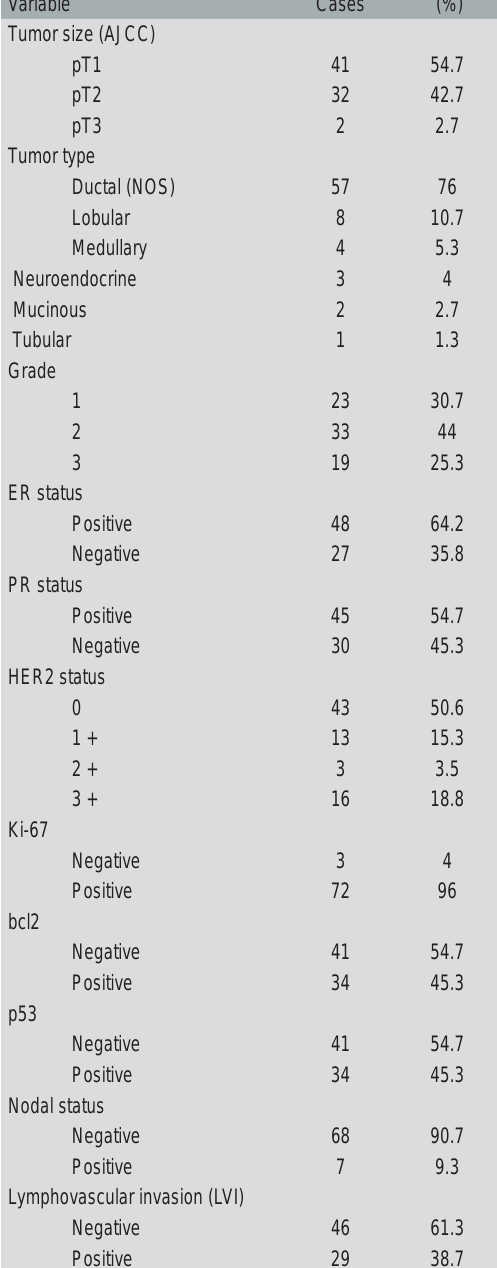
TABLE 1. Clinicopathological characteristics of the studied